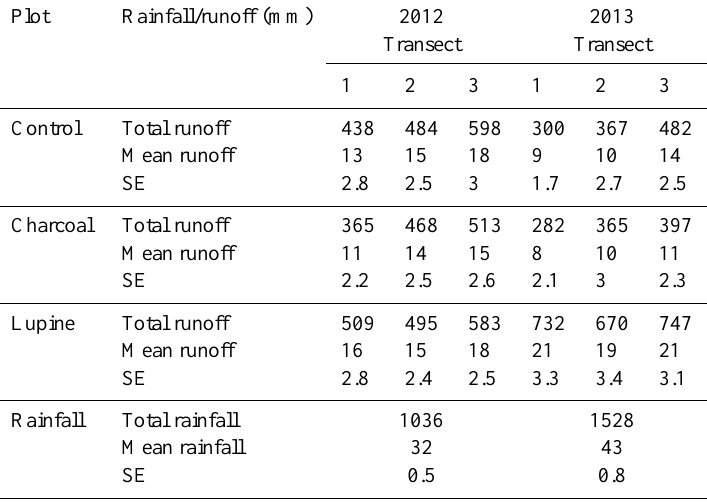
Table 2. Summary of total runoff during the year (“Total runoff”), average 3-day runoff in mm (“Mean runoff”) and standard error (SE ∗ ) in mm average of the plots in the transect for 2012 and 2013. The annual precipitation in 2012 and 2013 was 1036 and 1528mm, respectively. Plot Rainfall/runoff